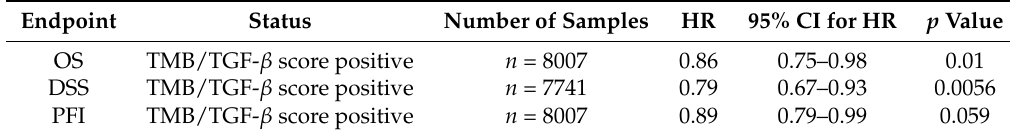
Table 2. Univariate Cox regression analysis of OS, DSS, PFI in the entire cohort included in the study.